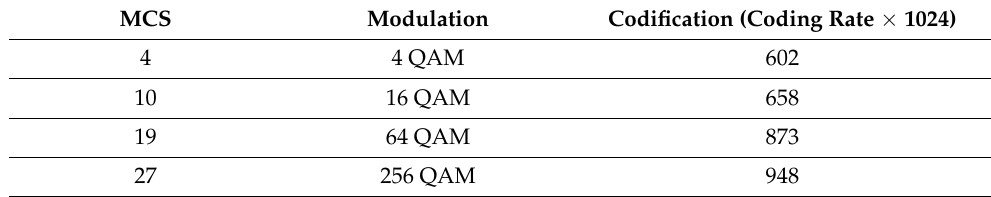
Table 5. Bandwidths, RBs, and number of subcarriers.